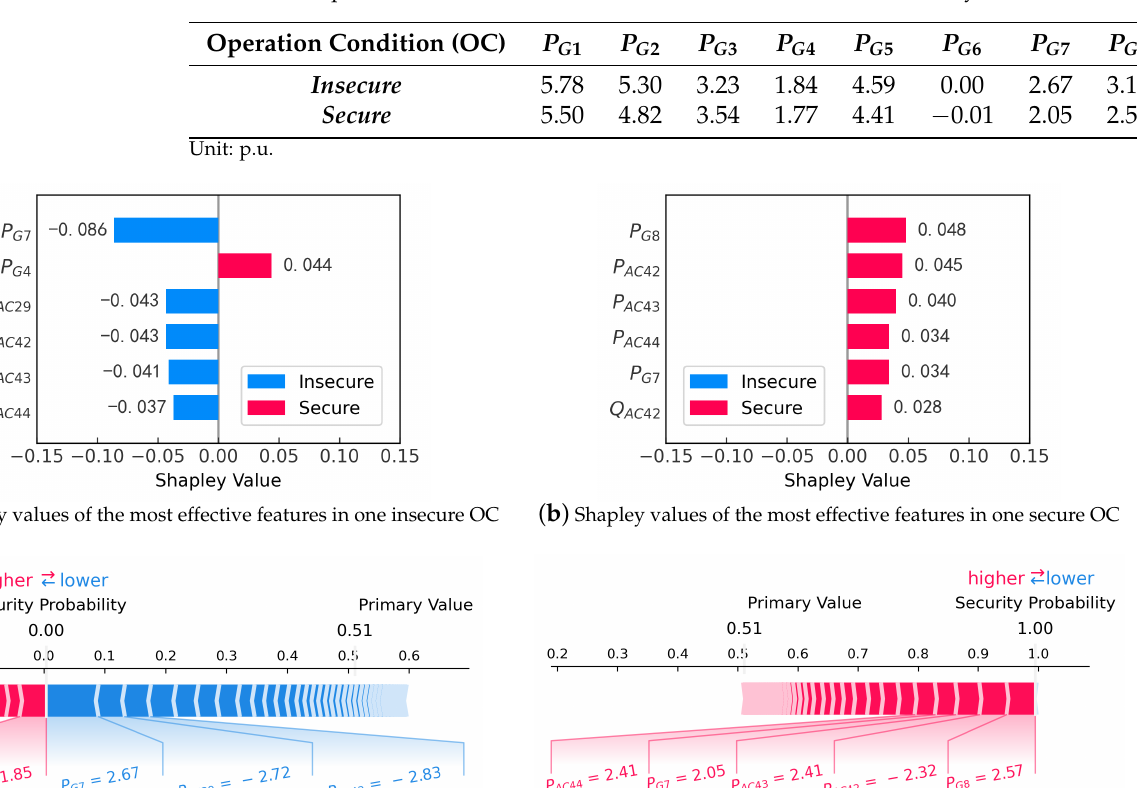
Table 1. Main parameters of an insecure OC and a secure OC in the CEPRI36 system.